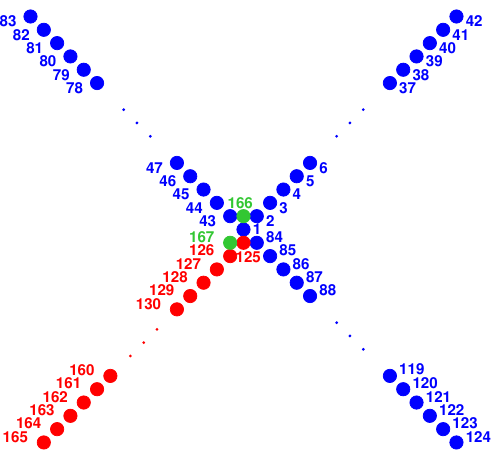
Figure 4. A cross-shaped array populated with 167 antennas. The red arm is translated with respect to the three others in blue, and the green antennas are added for calibration purposes. The spacing between the closest antennas, as illustrated, for example, by antennas #125 and #1, or by antennas #166 and #2, is set to d . As a consequence of the geometry, the spacing between the antennas along √ the arms is equal to 2 d